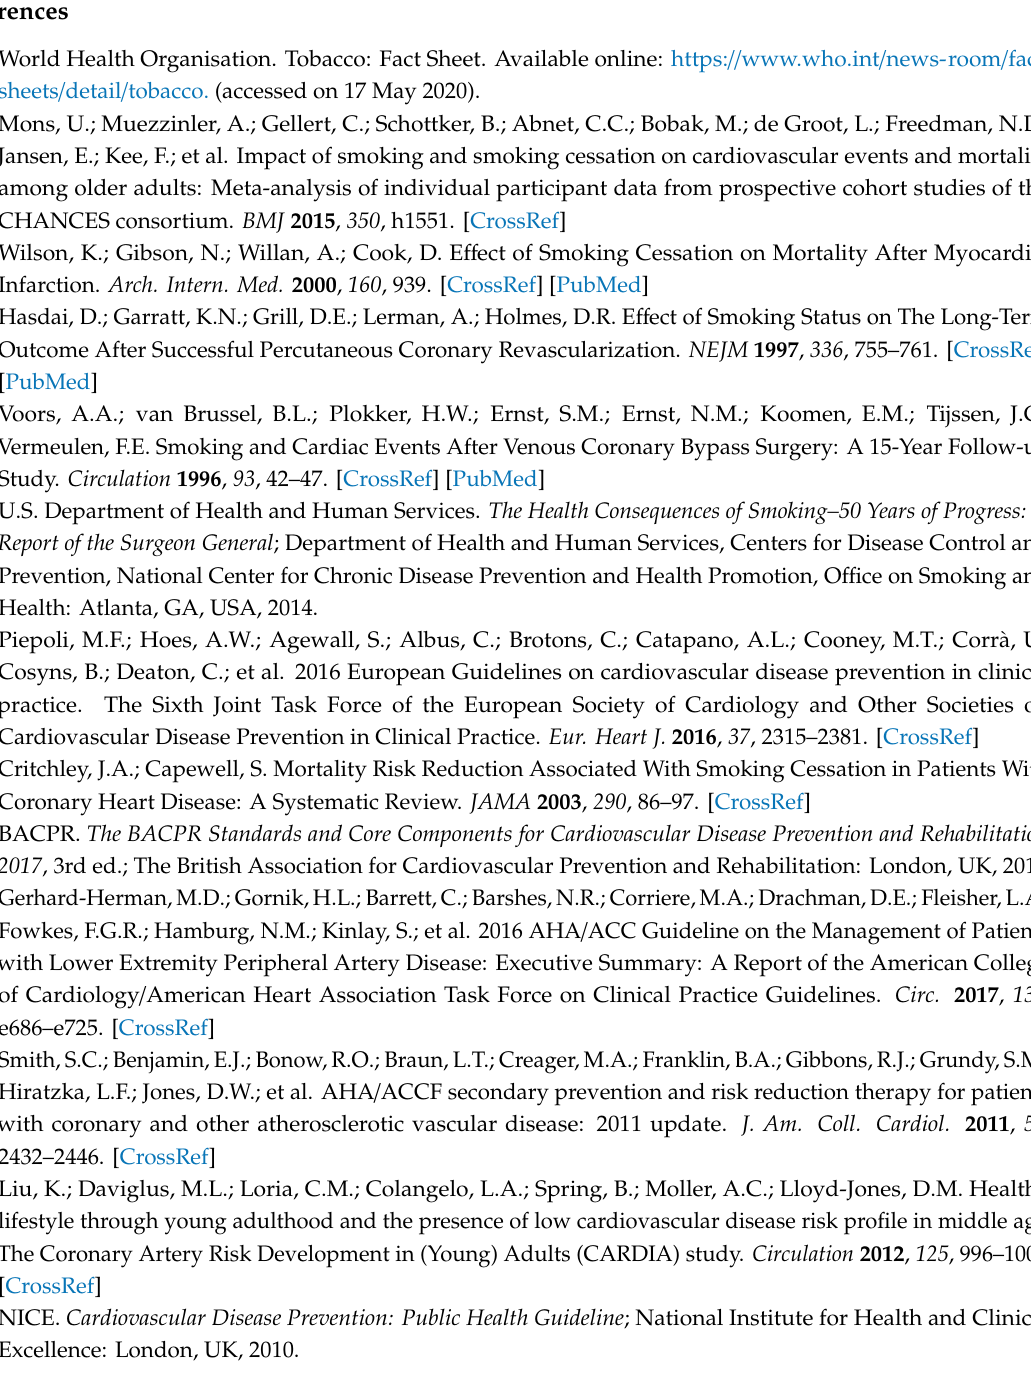
Table S1: STROBE Statement—checklist of items that should be included in reports of observational